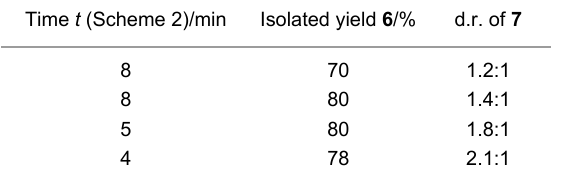
Table 1: Dependence of yield and e.r. on delay before